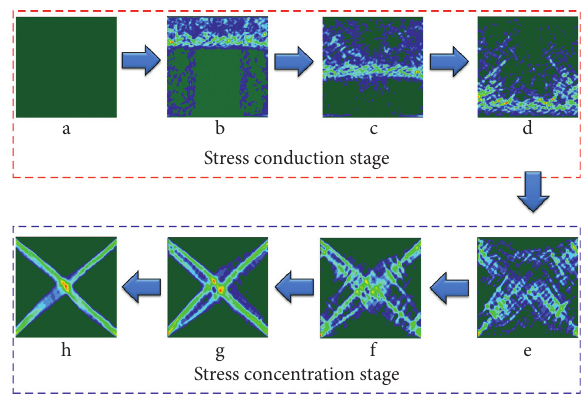
Figure 18: Formation of shear failure zone of numerical specimens of coarse-grained